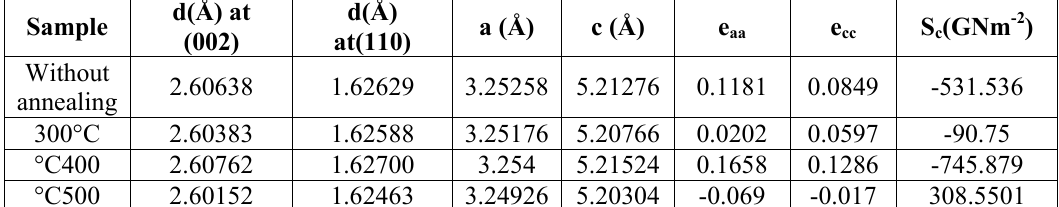
Table 2: Characteristics of the ZnO nanostructures obtained from XRD data.